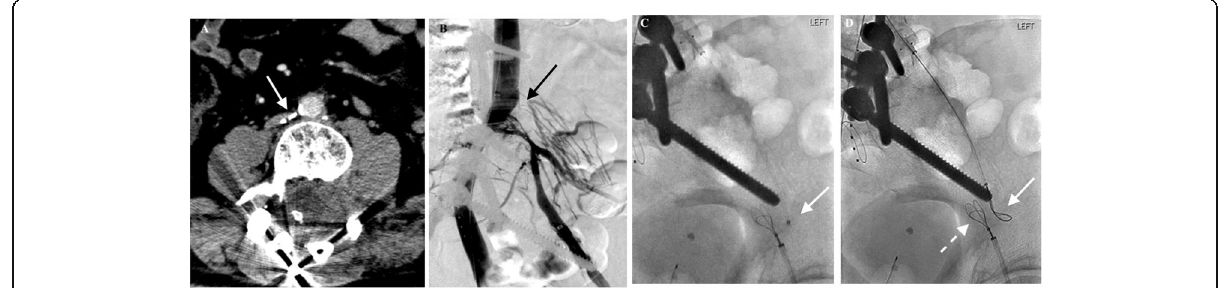
Fig. 1 a CT demonstrated clips at level of LCIV origin (arrow) from prior surgical ligation of the LCIV, which were likely contributing to chronic occlusion of the vessel and complex recanalization techniques required; b Initial LLE venogram in the extreme RAO view shows flush occlusion of LCIV (arrow), in addition to postoperative findings related to L4 corpectomy and posterior lumbar fusion hardware; c Sharp recanalization needle was advanced from the proximal LCIV in the direction of the LEIV into the extra-vascular pelvic space (solid arrow), thus bypassing the known occlusion, confirmed on hybrid CT; d The two snares could now be advanced above (solid arrow) and below (dotted arrow) the area of occlusion and were confirmed to be close to each other on both AP and oblique